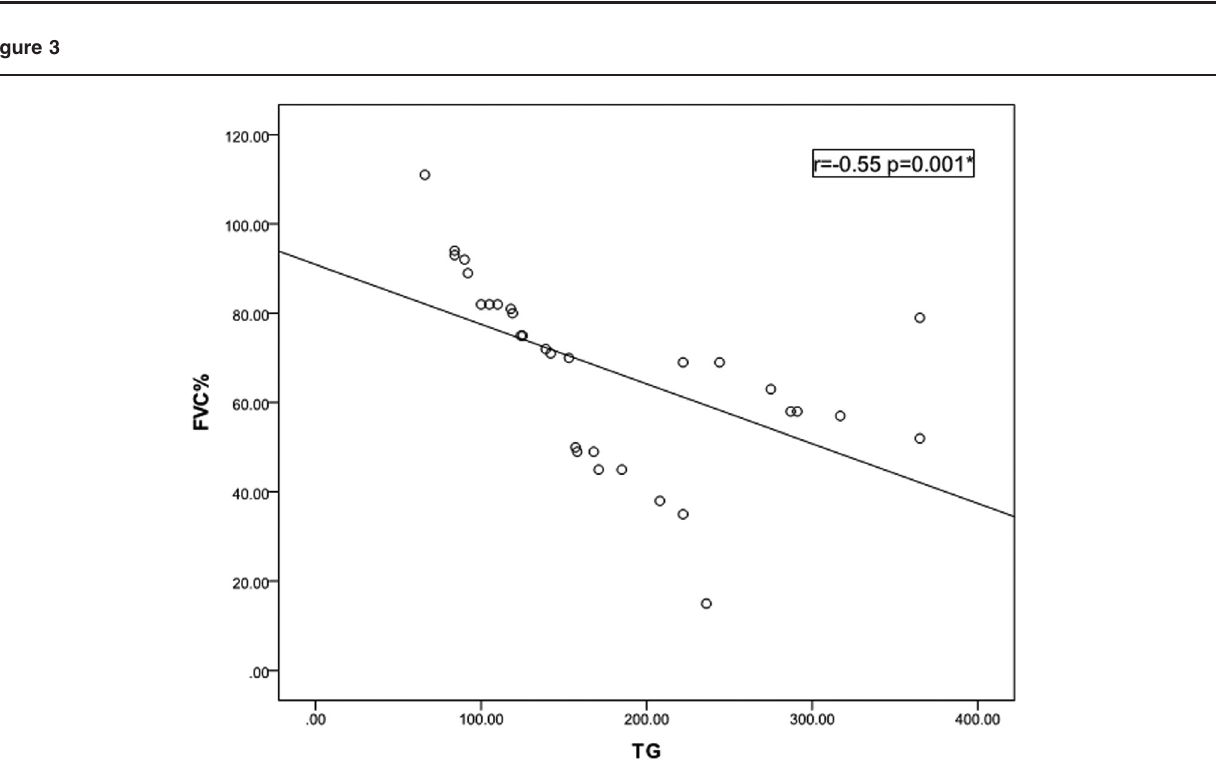
Correlation between FVC% and TG among patients with metabolic syndrome. FVC, forced vital capacity; TG,